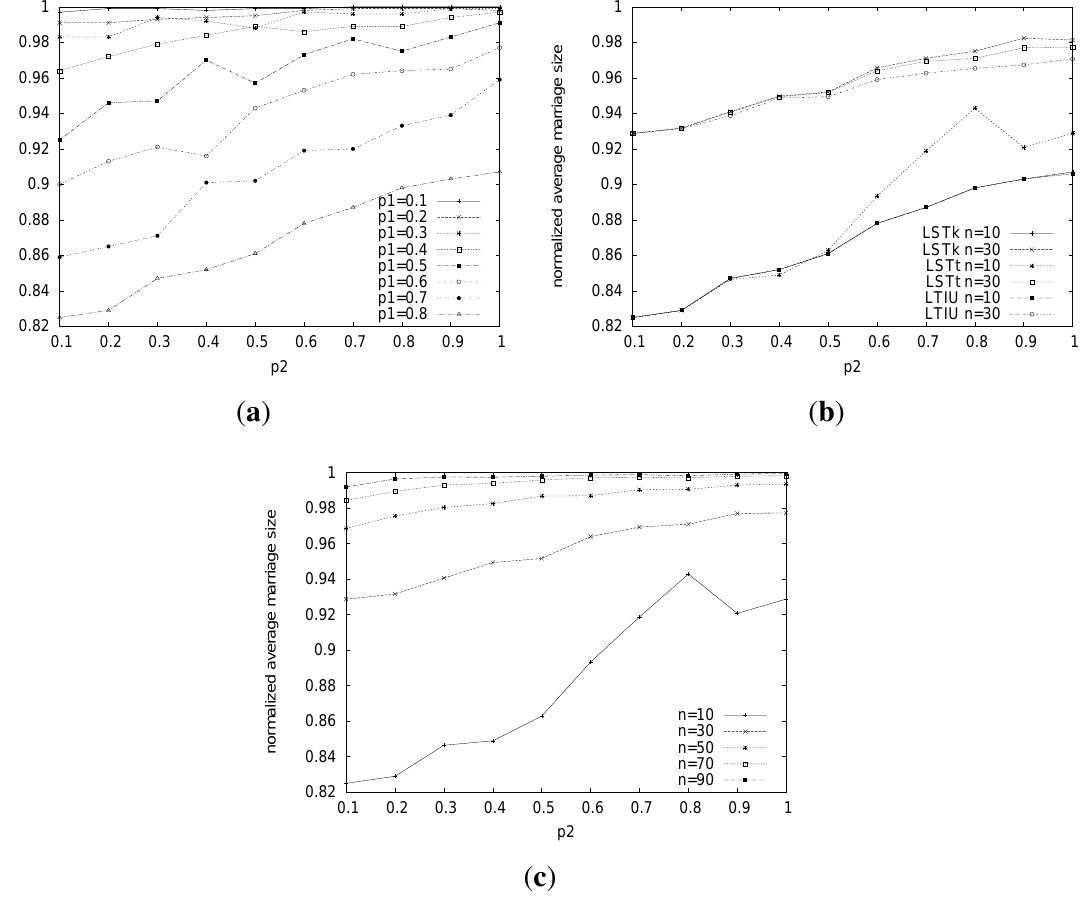
Figure 7. Normalized average size of marriages for LSTk, LSTt and LTIU. ( a ) Normalized average size of marriages found by LSTk using k = 50% on Stable Marriage with Ties and Incomplete lists (SMTIs) of a size of 10; ( b ) normalized average size for LSTk, LSTt and LTIU on problems of size 10 and 30. Fixing p = 0.8, k = 50% and t = 0 : 5 ; ( c ) normalized 1 average size for LSTt varying n and fixing p = 0.8 and t = 0 : 5 . 1